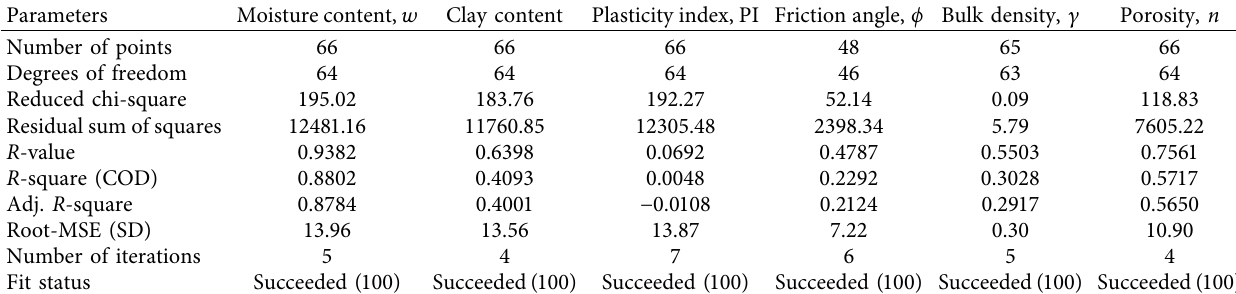
Table 2: Summary statistical analysis for soil parameters with resistivity.